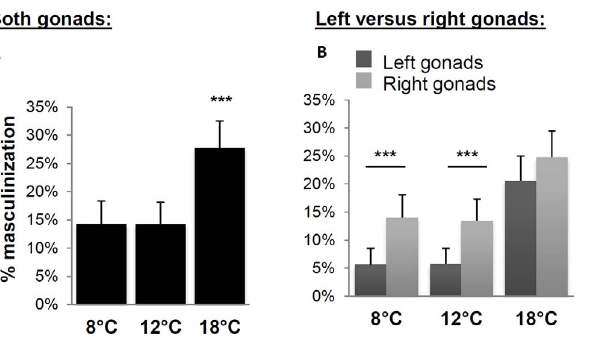
Fig. 2. Overall effect of different rearing temperatures on the masculinization rate in Experiment A (pool of four different mal -carrying progeny). Panel A: Individual masculinization rates (each individual is considered masculinized when at least one gonad is masculinized) different temperature treatments (8, 12 and 18 ˚ C) (in percentage ¡ Confidence Interval at p 5 0.05; x 2 ; *** p , 0.001). Panel B: Masculinization rates of left versus right gonads following different temperature treatments (8, 12 and 18 ˚ C) (in percentage ¡ Confidence Interval at p 5 0.05; x 2 ; *** p , 0.001). Numbers of animals analyzed at 8 ˚ C n 5 357, 12 ˚ C n 5 386 and 18 ˚ C n 5 375.